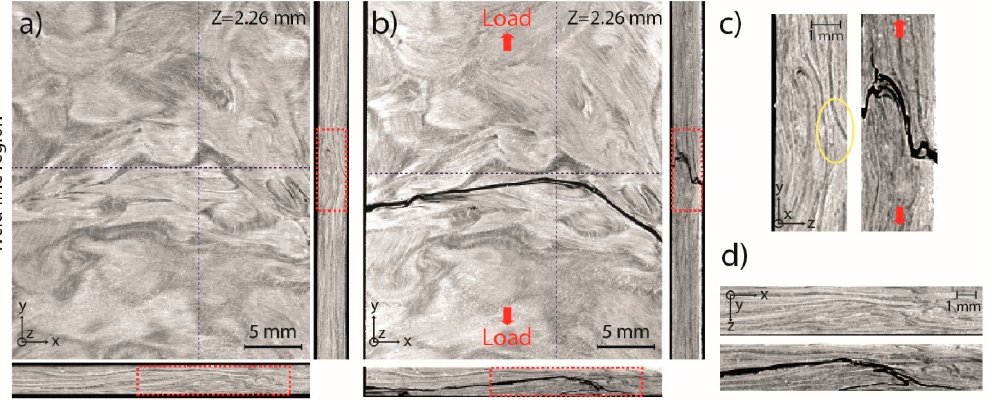
Figure 11. Butt tensile coupon micro-CT, in plane (upper) out-of-plane (lower); ( a ) before testing, ( b ) after testing; ( c , d ) larger sections of both scans for ( c ) in-plane and ( d ) out-of-plane, also before and after failure.